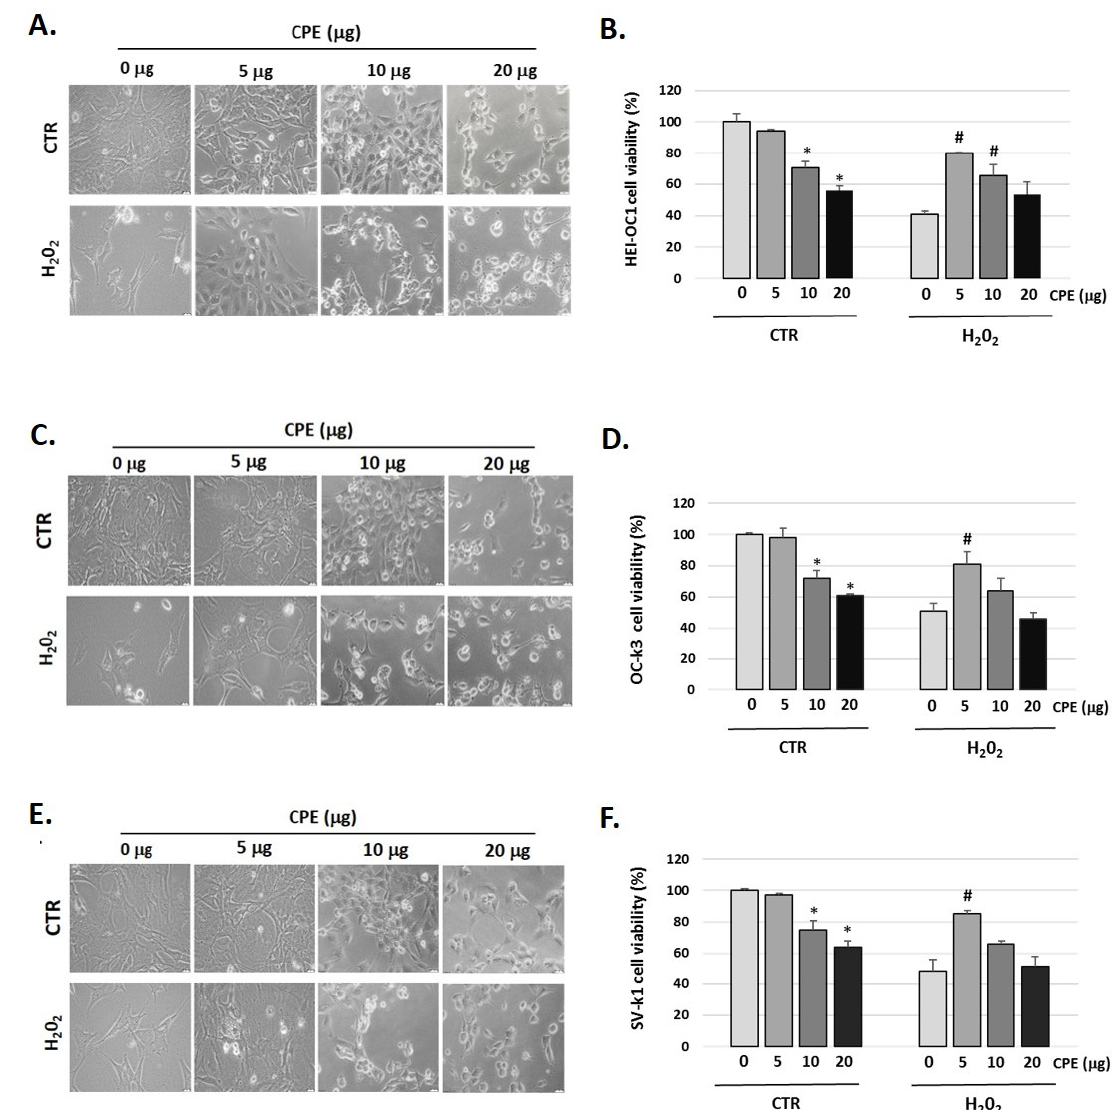
Figure 1. Cocoa increases the viability of senescence auditory cells. Representative images of morphological changes of ( A ) HEI-OC1, ( C ) OC-k3, and ( E ) SV-k1 auditory cells post-treatments. Cells were visualized under the Olympus CKX41 microscope (at 20 × magnification) and the cellSens Entry imaging system. Scale bars: 100 µ m. Cell proliferation and viability measured by CyQUANT™ MTT Cell Proliferation Assay Kit of auditory cells post treatments in ( B ) HEI-OC1; ( D ) OC-k3 and ( F ) SV-k1 cells. Experimental groups: CTR group (0, 5, 10, and 20 μ g/mL of CPE for 20h) and H 2 O 2 group (CPE-pre-treatment at 0 and 5 μ g/mL for 20h and H 2 O 2 -post-treatment at 100 μ M for 1h). Results are means ± SD (n = 3). * p < 0.05 vs of CTR group (0 μ g of CPE); # p < 0.05 vs. H 2 O 2 group (0 μ g of CPE).